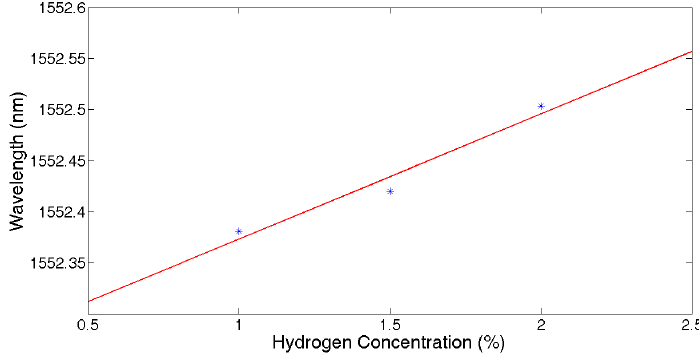
Figure 12. Central wavelength vs. hydrogen concentration.